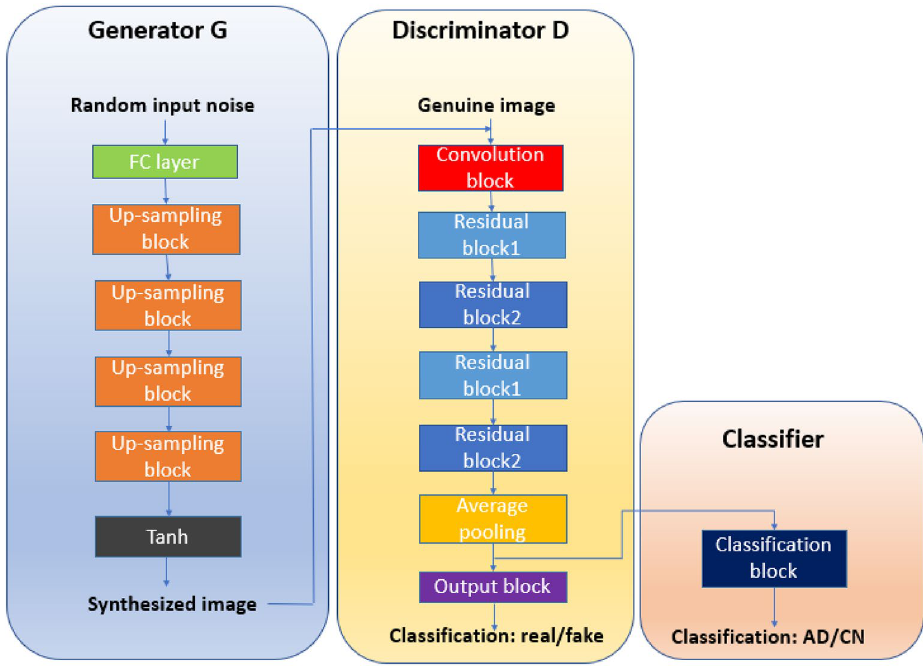
Figure 1. Flowchart of the proposed 3D